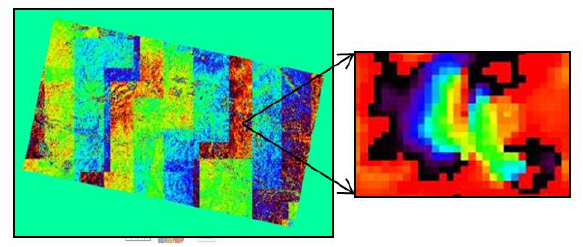
Figure 2. Filtered Interferogram and subsidence fringe after atmospheric phase delay